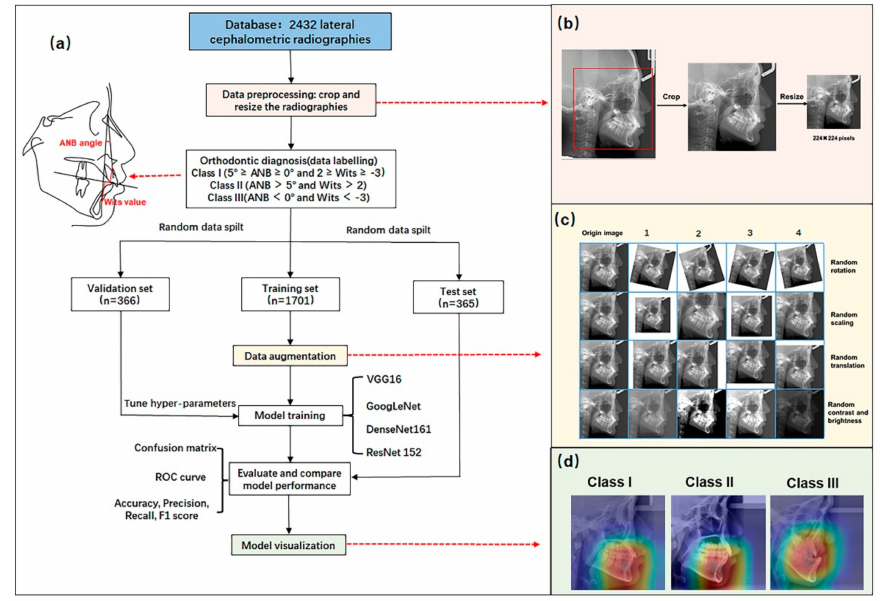
Figure 1. ( a ) Flow chart of the experimental process. ( b ) Schematic diagram of data preprocessing. ( c ) Schematic diagram of data augmentation. ( d ) Schematic diagram of model